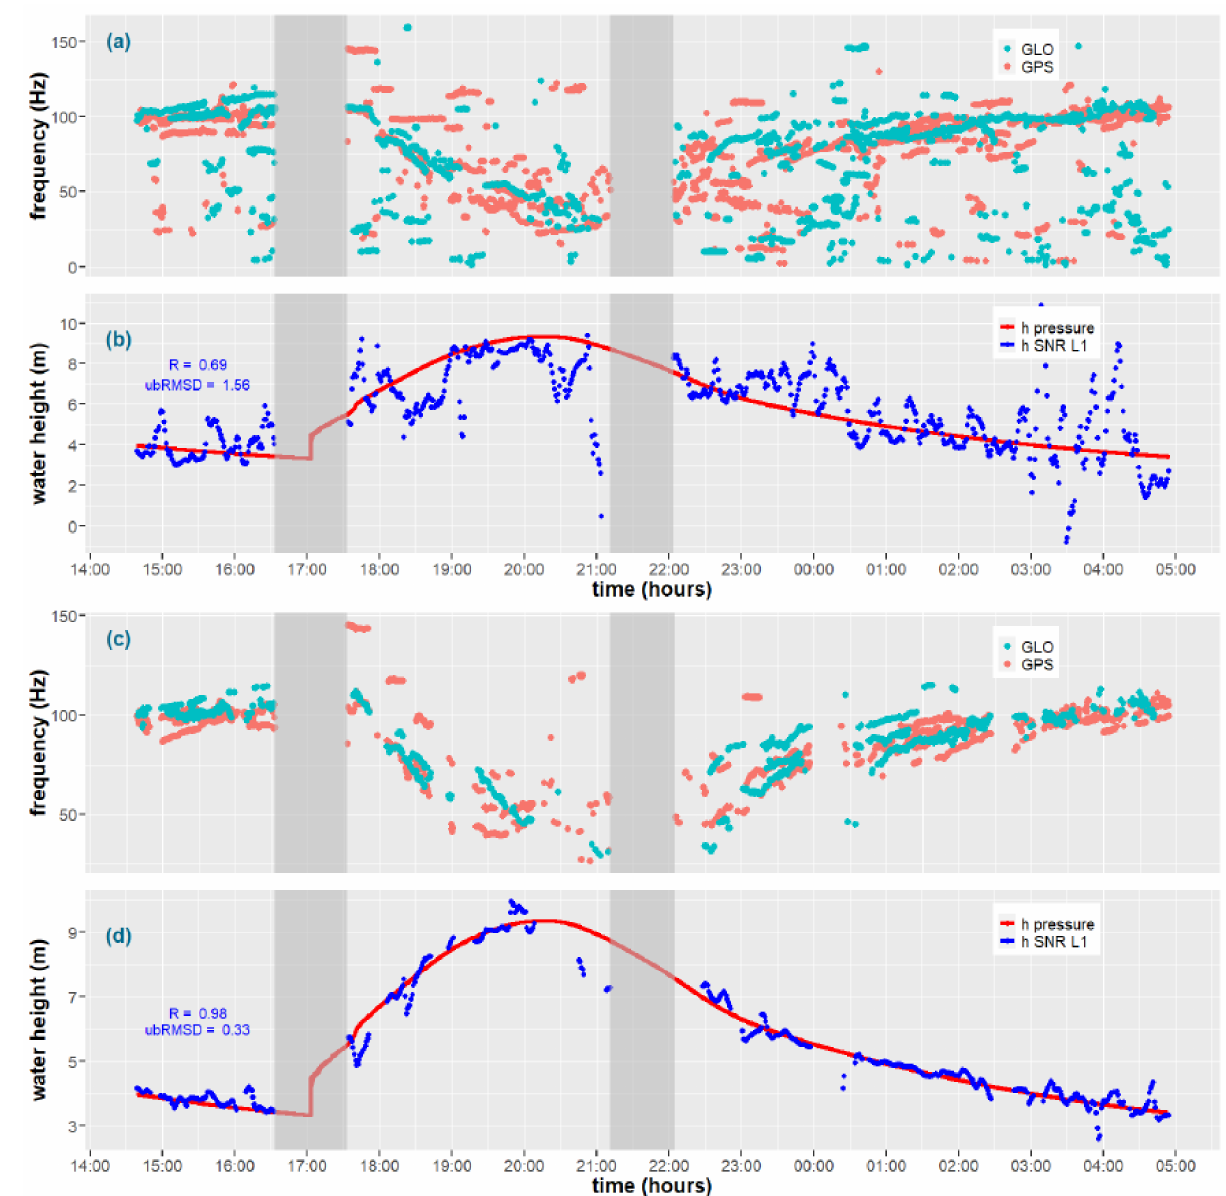
Figure 4. Dominant frequencies extracted from GPS (green) and GLONASS (orange) satellites using the LSP, and river heights inverted with the dynamic SNR method (blue) compared to pressure water levels (red). ( a , b ) (cid:101) f and h from raw LSP output respectively; ( c ) frequencies filtered out after multipeak rejection with parameter k = 0.6 and iterative LSE; ( d ) concordant time series of water levels estimated with iterative LSE. Grey areas are masks due to tidal bore occurrence (17 h) and data gaps (21–22